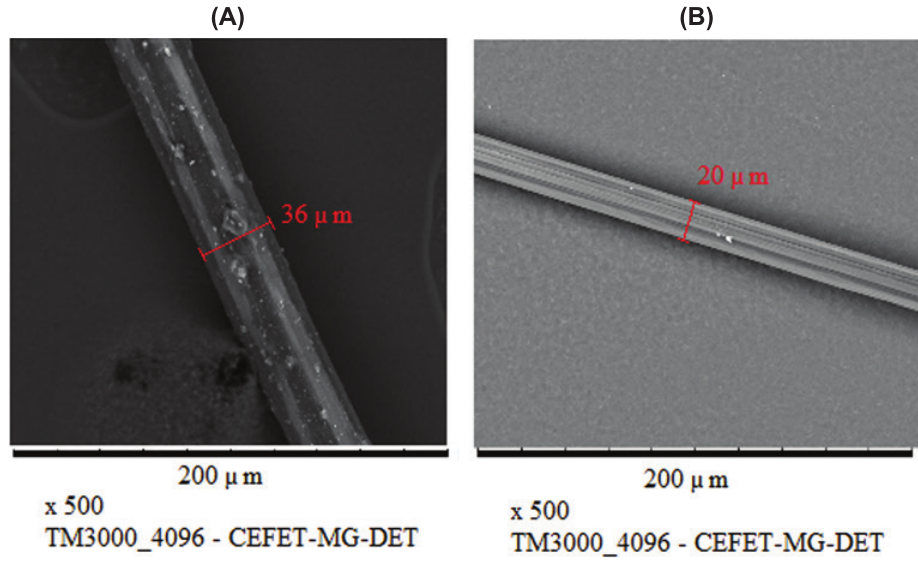
SEM images (magnification: 500x) of PP fiber (a) and HMPE fiber